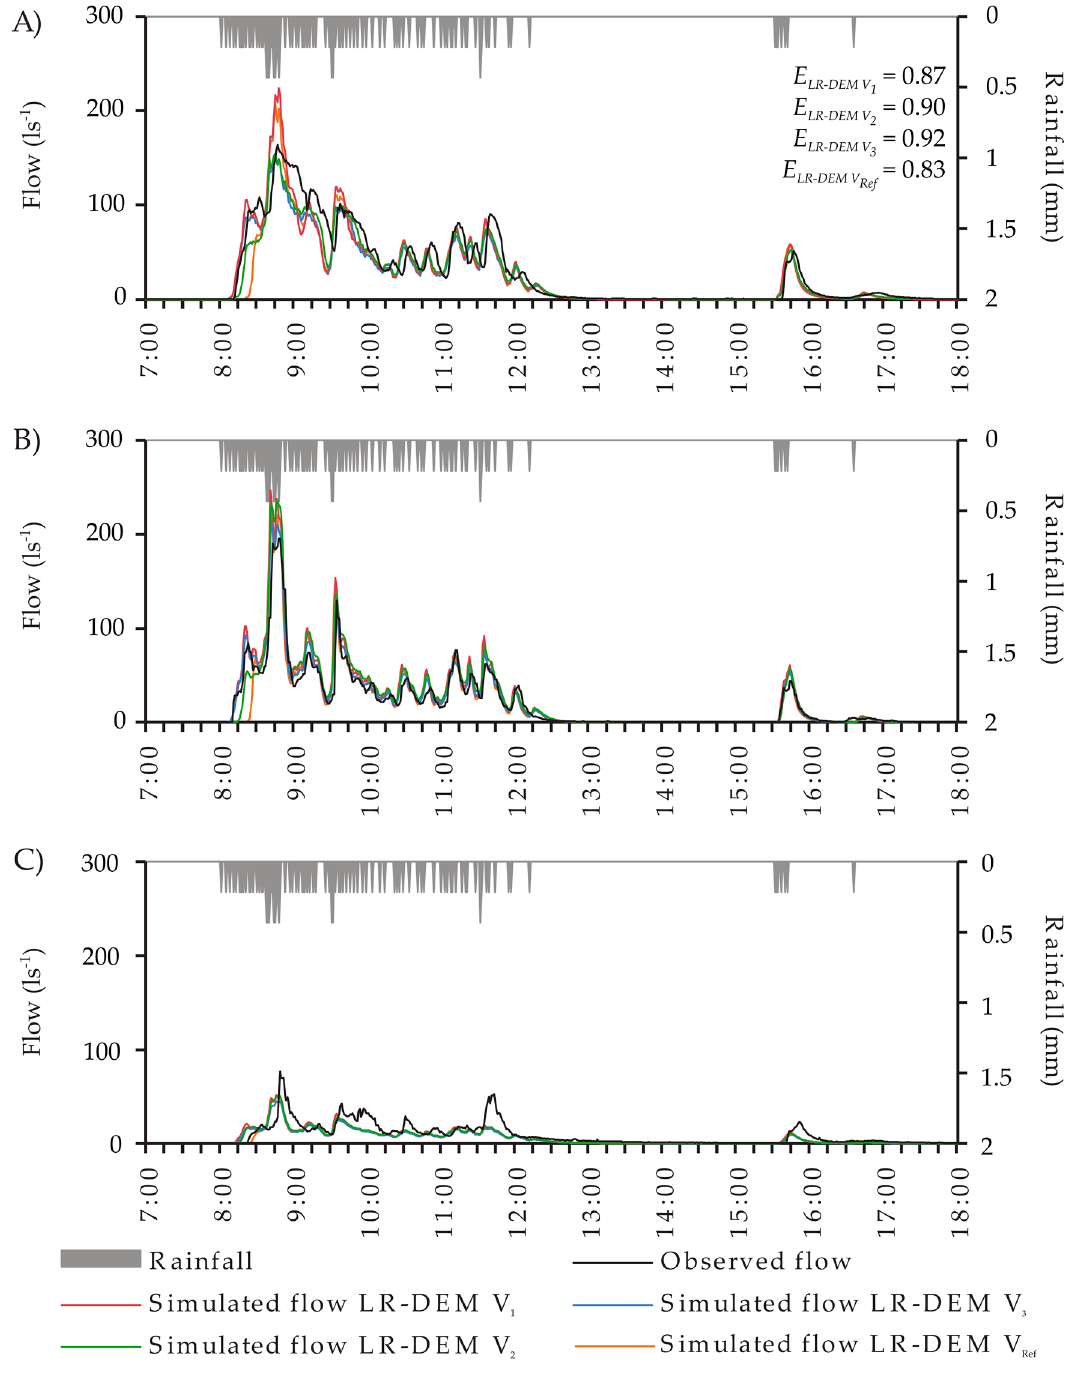
Figure 5. Observed and simulated (LR ‐ DEM) flow for ( A ) Catchment 1; ( B ) Catchment 2; and ( C ) Catchment 3, and the model efficiency E for the parameter sets V 1 , V 2 , V 3, and V Ref (event rainfall depth 22.0 mm, peak intensity 1.73 mm/5